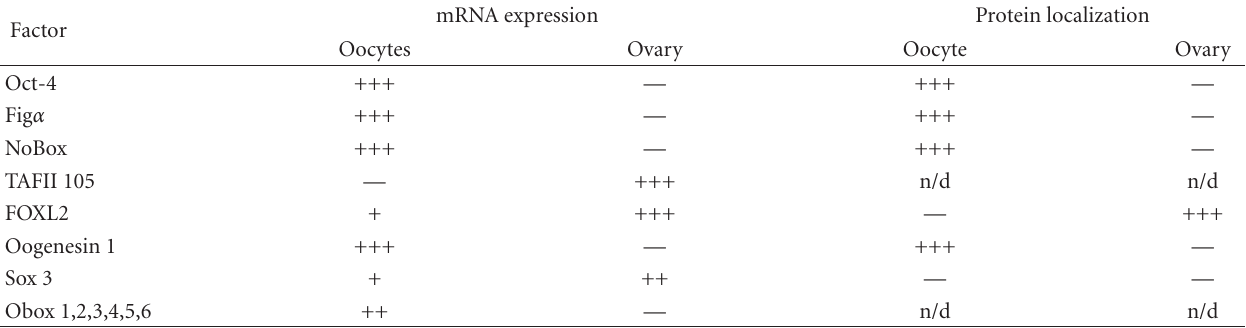
Table 5: Transcription factors related to follicular and oocyte development [14].